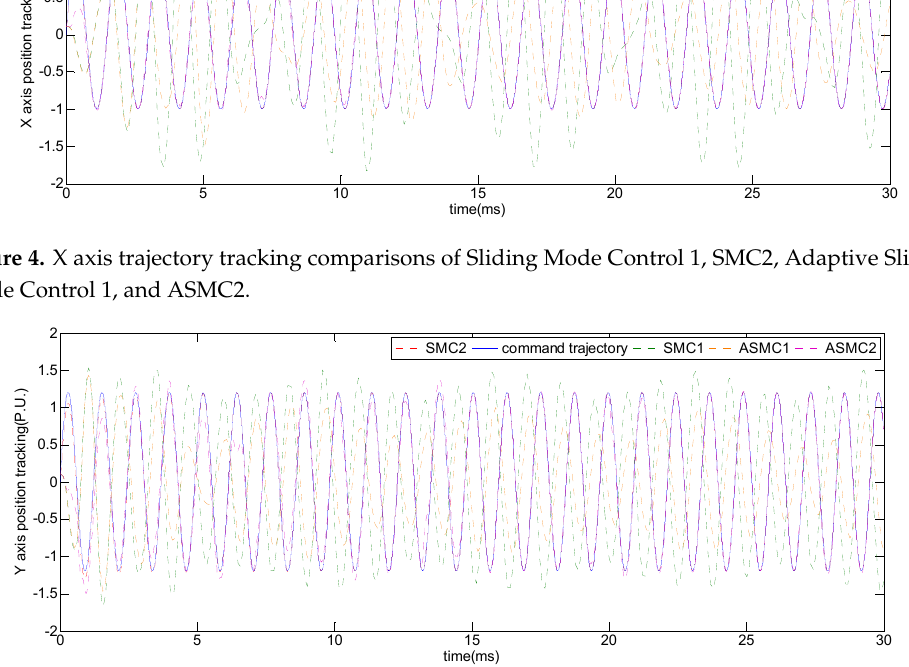
Figure 5. Y axis trajectory tracking comparisons of SMC1, SMC2, ASMC1, and ASMC2.